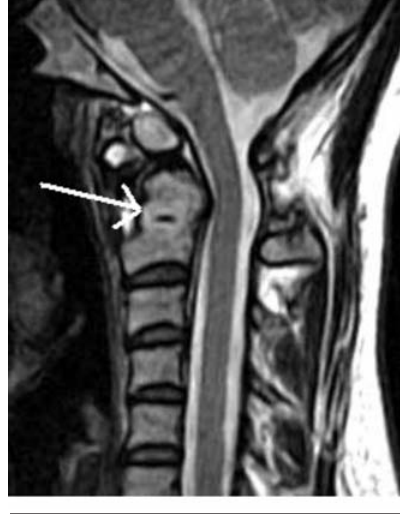
Figure 2. A T2WI sagittal MRI reveals a cystic lesion of the dens with retropulsion of the posterior longitudinal ligament and kyphotic angulation of the cranio-cervical junction – a vivid enhancement after con- trast. However, it is still limited to the pre- vertebral space by the anterior longitudinal ligament (white